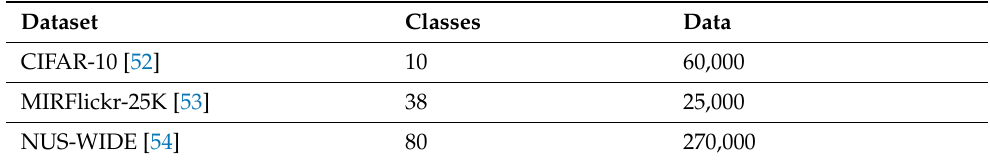
Table 1. Quantitative analysis of the